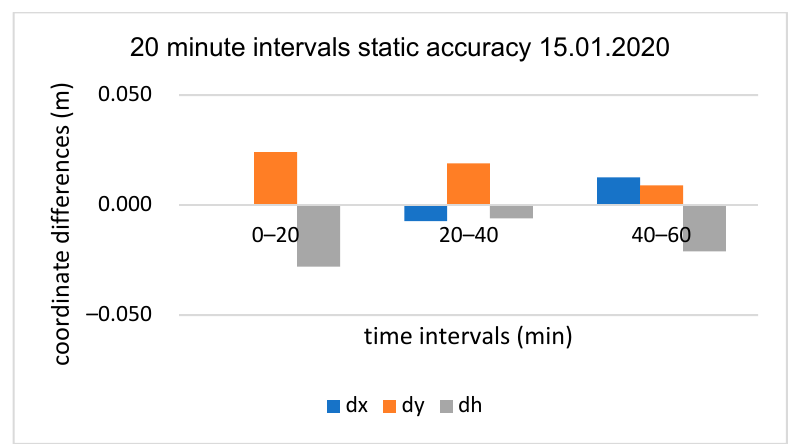
Figure 7. 15 min sub-session positioning results for initial test, baseline OPNT–P30Pro (4 km).